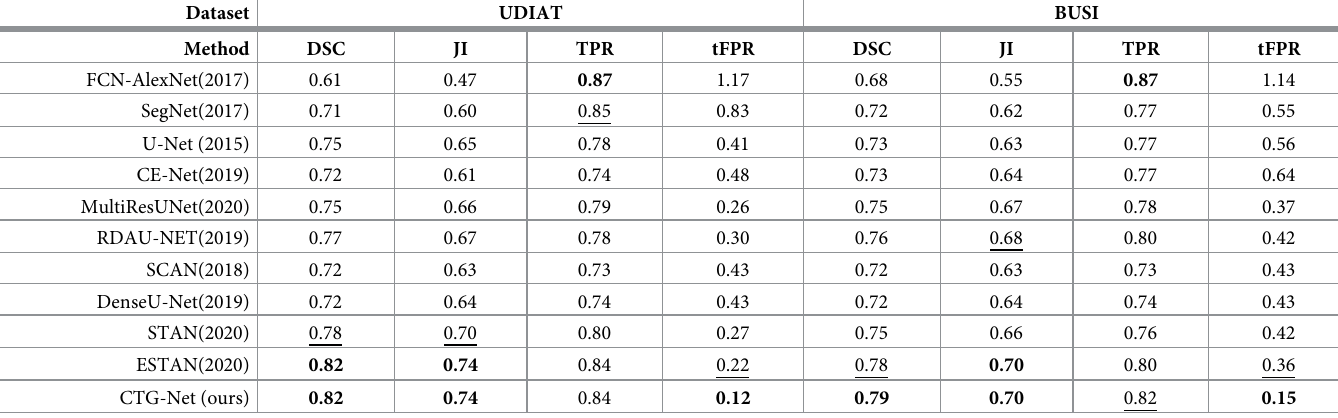
The best results are indicated in boldface, and the second-best results are underlined.